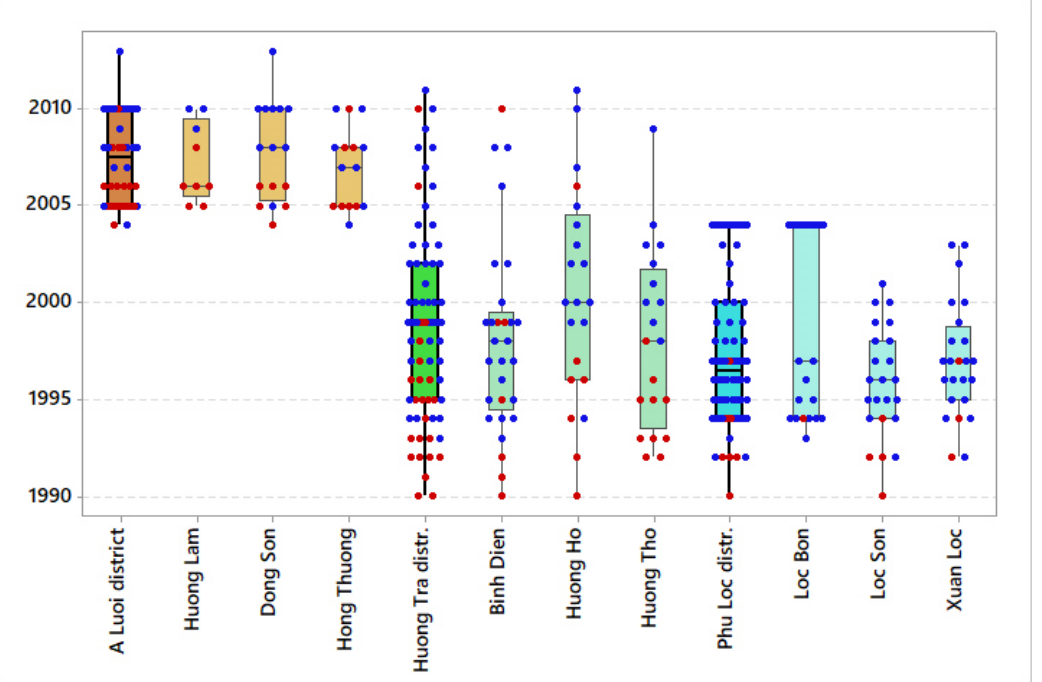
Figure 2. Boxplot graph illustrating the timing (years) of the initial establishment of acacia plantation plots, as indicated by the respondents of the visited communes within each of the three districts. The dots indicate individual data points. Red dots represent the establishment of acacia plots by respondents who had participated in a state-led plantation program; blue dots indicate ‘self-motivated’ initiation of plantations (this may still have been variously supported by certain development programs). Boxes indicate the 1st, median, and 3rd quartiles; spikes the 0th and 100th percentiles. All data from farmer interviews.